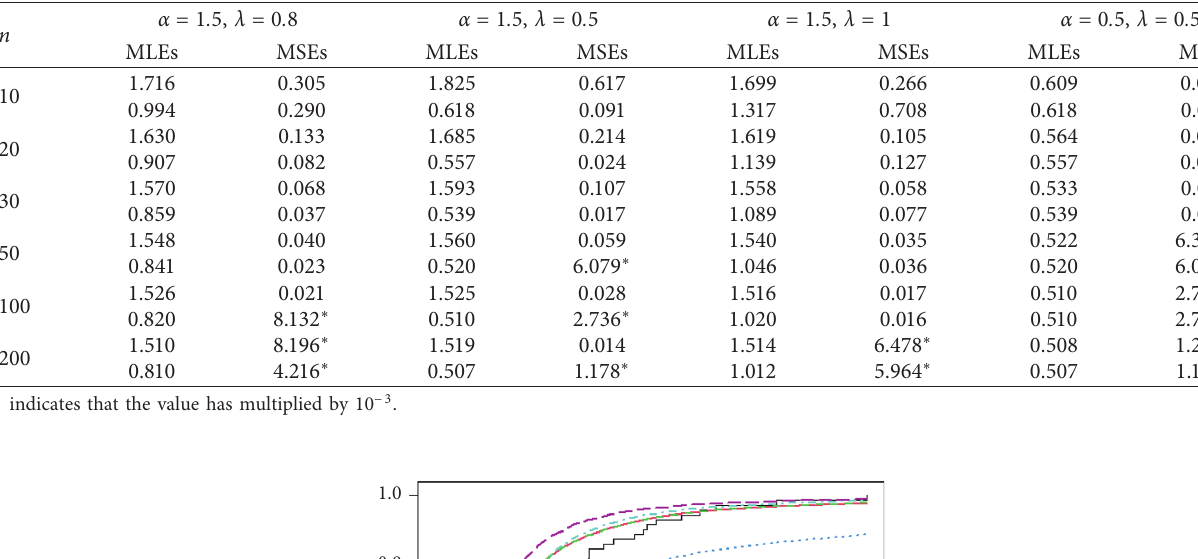
Table 2: MLEs and MSEs of SHLIR distribution.